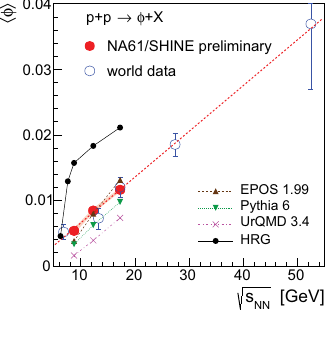
Figure 4. Energy dependence of total yields of φ mesons in p + p collisions. World data come from Refs. [10, 17–20]. Total uncertainties are shown; for preliminary NA61 / SHINE results total uncertainties are smaller than markers. Red dashed line is fitted to guide the eye. Regarding models see